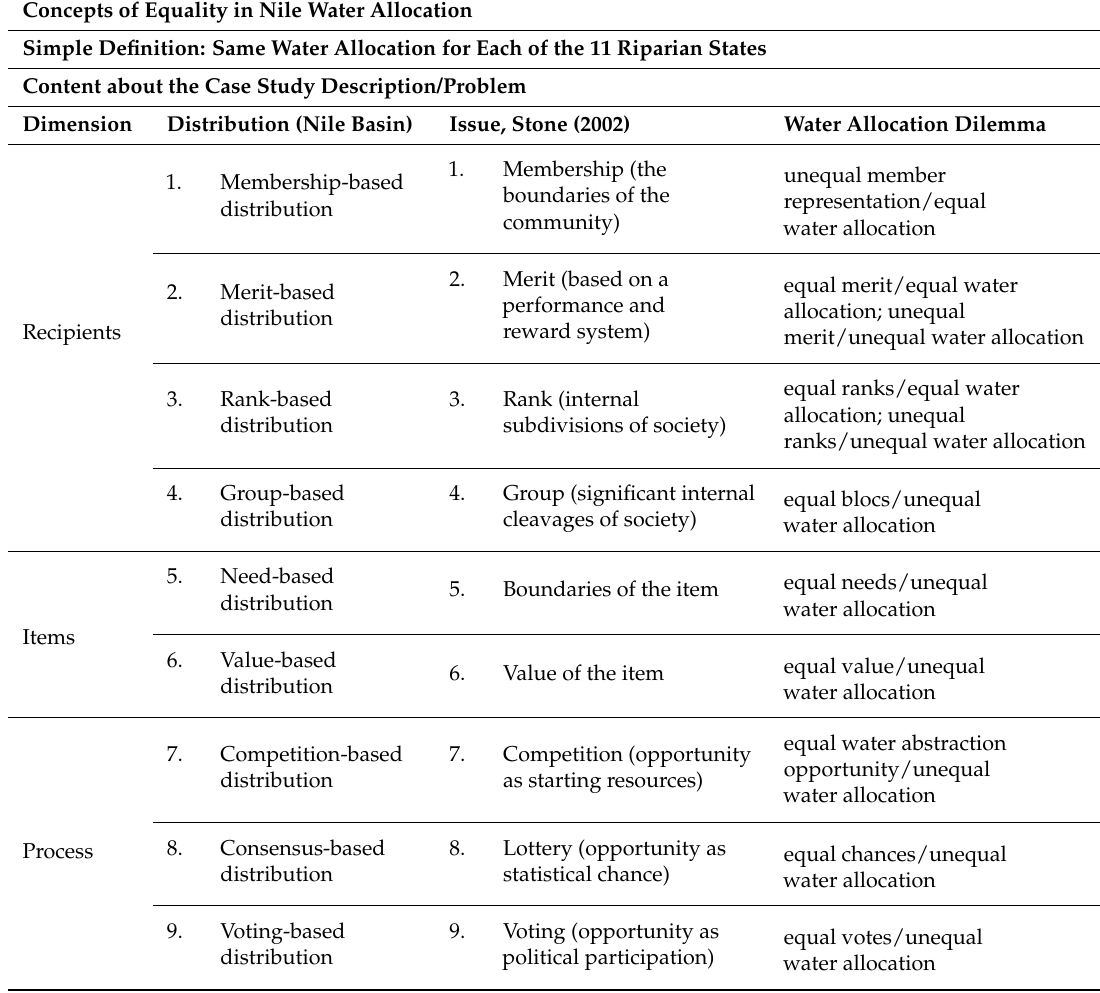
Table 1. Concepts of equality in Nile water allocation. Customized from Stone